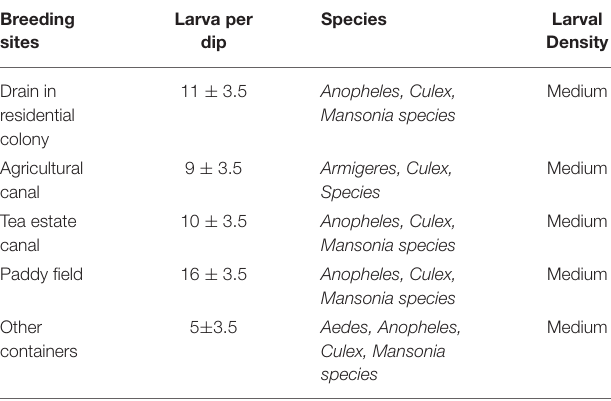
TABLE 2 | Larval density of mosquito species in the Dolonibasti sub-center. Breeding